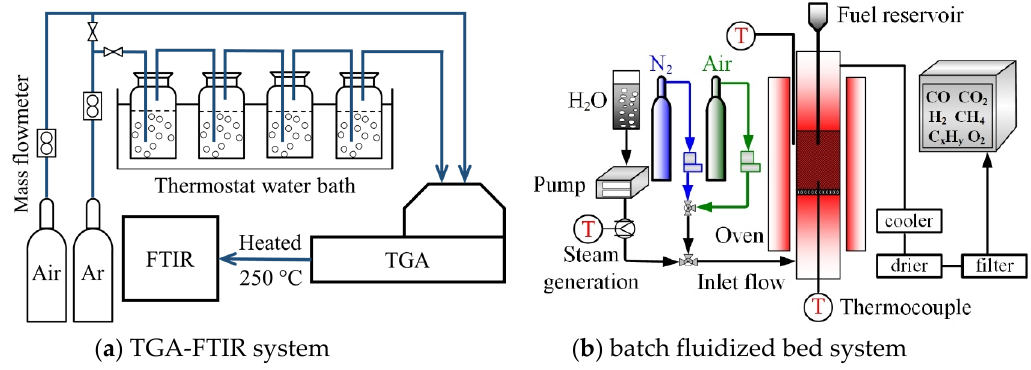
Figure 1. The schematic of the TGA-FTIR and batch fluidized bed system.